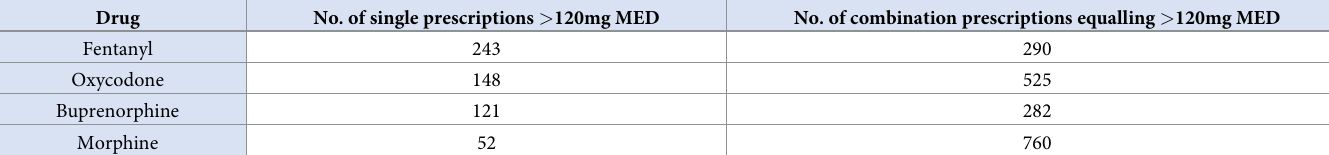
Table 4. Single opioid prescriptions compared with combination prescriptions > 120mg MED.